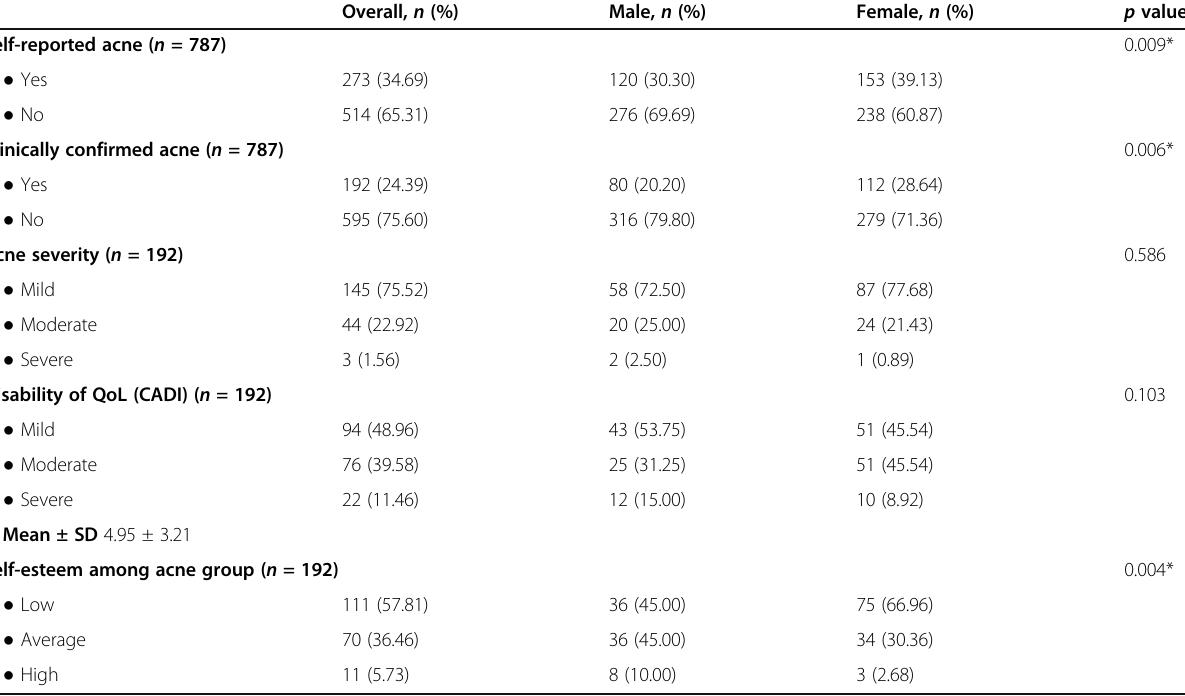
Table 1 Acne among secondary school-aged adolescents, Alexandria, Egypt,